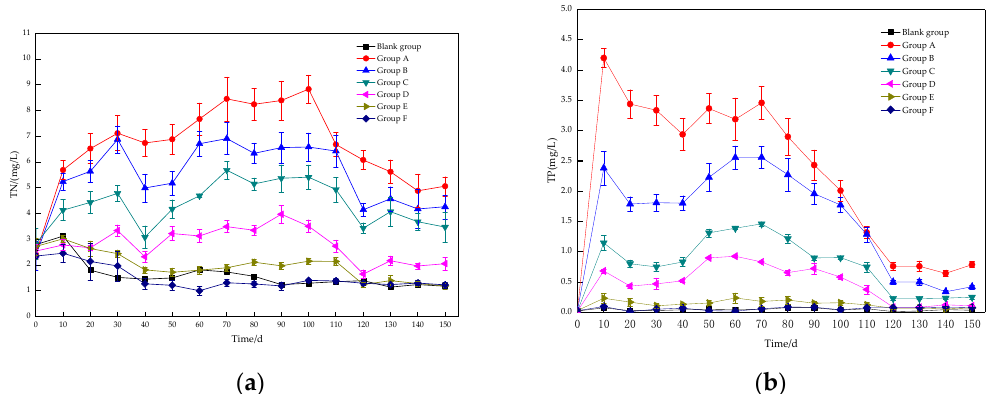
Figure 8. Changes in the nutrient concentrations in water during the macrophyte decay period with time: ( a ) TN and ( b ) TP.